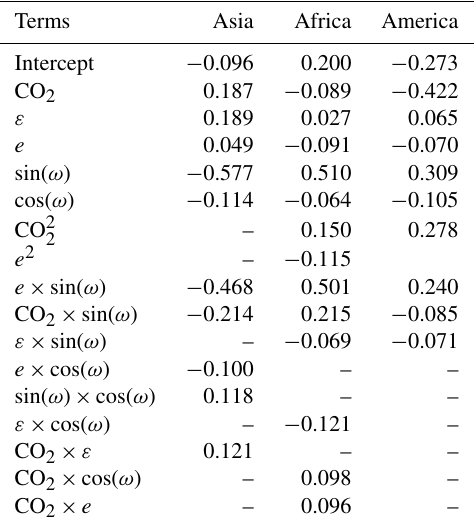
Figure 11. Main effects of forcing parameters on the first three principal components of JJA temperature (a) and JJA precipita- tion (b) . Table 7. Linear models derived from normalised forcing functions and monsoon